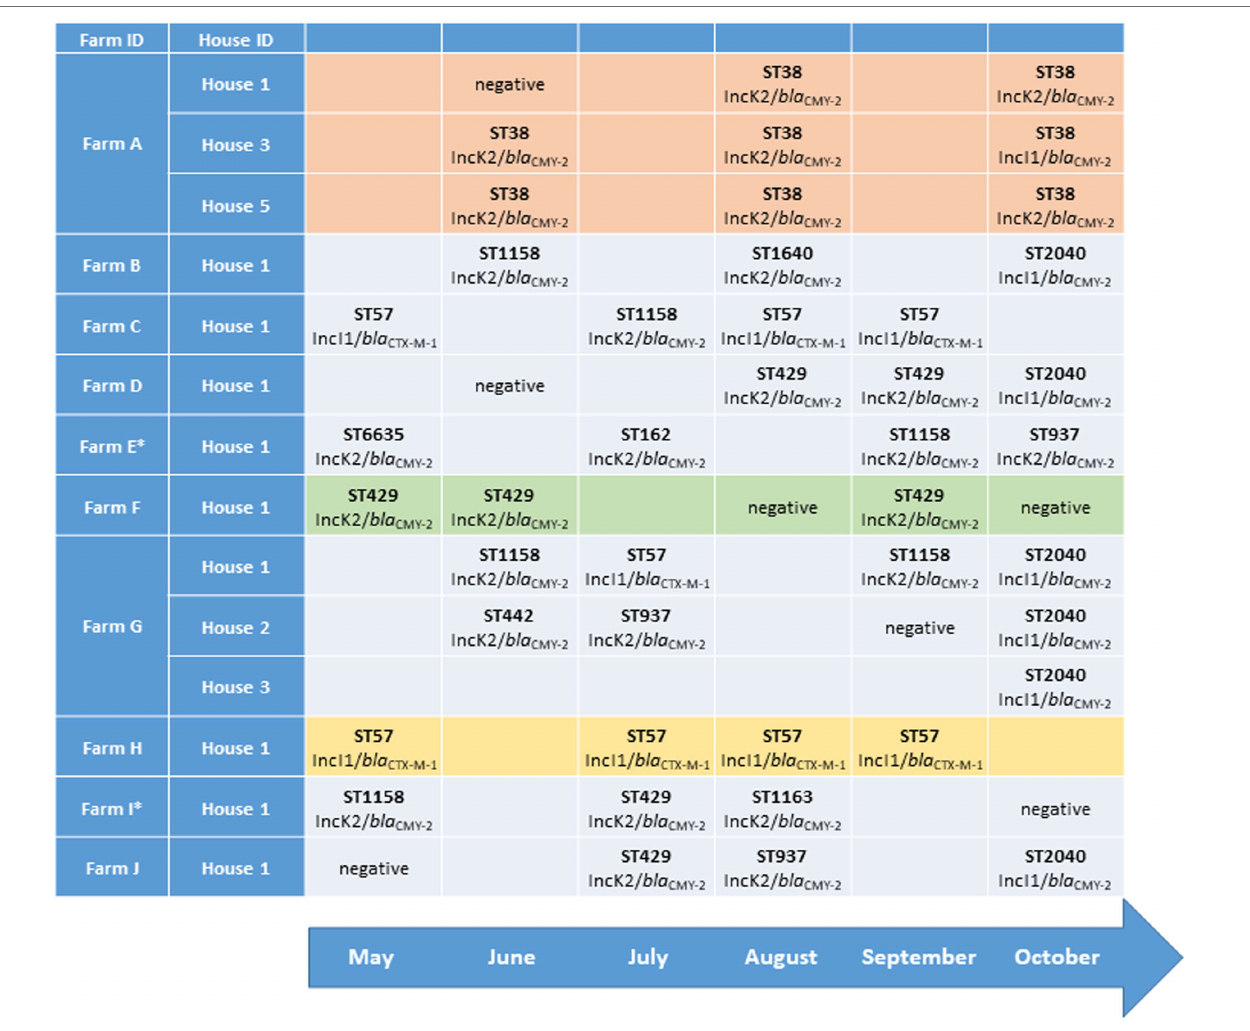
FIGURE 1 | Multilocus sequence type (MLST), plasmid replicon and extended-spectrum cephalosporin (ESC) resistance gene associated with ESC-resistant Escherichia coli isolated from different broiler flocks on 10 broiler farms sampled during May–October